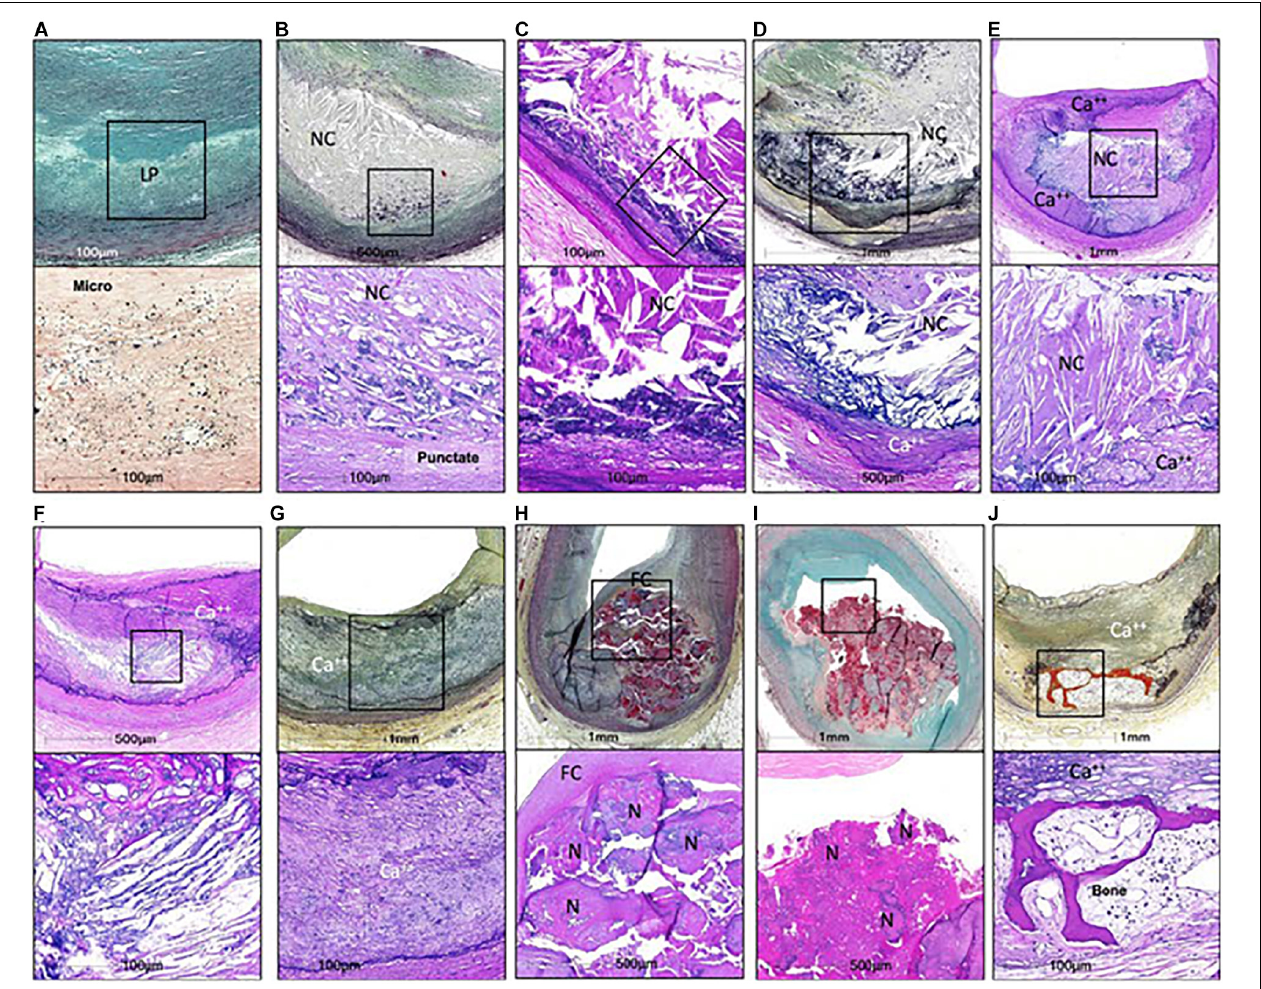
FIGURE 1 | Calcifications in human coronaries. (A,B,D,G,H,I,J) Images in the top row are Movat pentachrome stained, and (C,E,F) Images are H&E stained; lower row shows high power image; corresponding to (A) Is Von Kossa staining and all others are H&E. Non-decalcified arterial segments (A) And all others are decalcified segments (B–J) . (A) Pathological intimal thickening characterized by a lipid pool (IP) that lacks VSMCs. Corresponding high power image (Von Kossa staining) of the boxed area shows microcalcification < 15 µ m in diameter within the LP. (B) Fibroatheroma showing an early necrotic core (NC) infiltrated by macrophages which are calcified, seen as punctate ( ≥ 15 µ m) areas of calcification. (C) Fibroatheroma with a late NC and fragmented calcification seen toward the medial wall. (D) Late fibroatheroma with larger area of calcification occupying an area greater than 1 mm that shows calcification of the NC. (E) Fibrocalcific plaque with sheet calcification and calcifying NC, which is incompletely calcified. (F) Fibrocalcific plaque showing sheet calcium with both fibrous tissue and NC completely calcified. (G) Fibrocalcific plaque with sheet calcium without a NC. (H) Nodular calcification showing fragment of calcium separated by fibrin and lumina I coverage by fibrous cap. (I) Calcified nodule showing nodules of calcium within the lumen and an overlying thrombus. (J) Fibrocalcific plaque with an area of ossification at the edge of sheet calcification. Ca ++ , calcification; FC, fibrous cap; H&E, hematoxylin and eosin; N, nodule. From Jinnouchi et al. (2020), with permission from